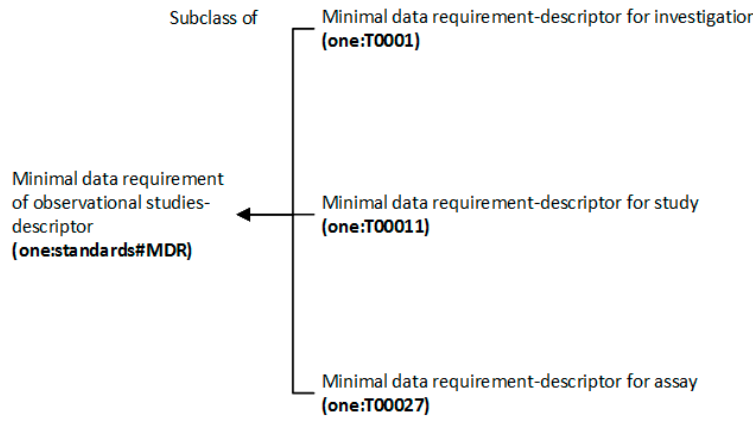
Nutrients 2019 , 11 , 1300 Figure 3. The ontology taxonomy of minimal data requirements. Figure 3. The ontology taxonomy of minimal data requirements.